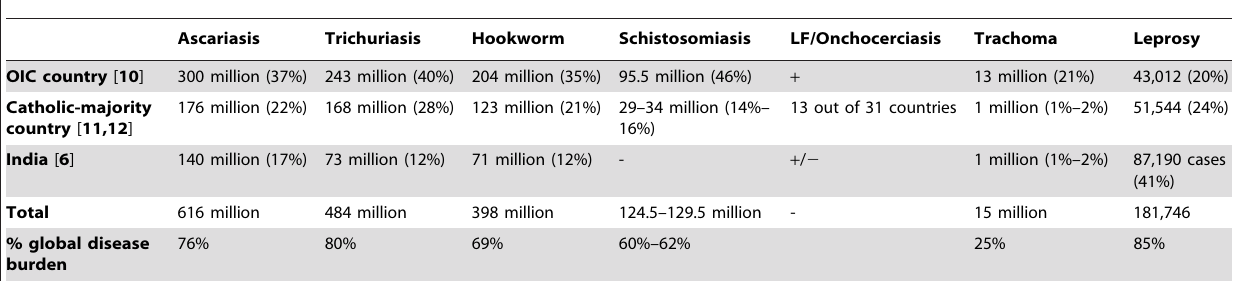
Table 2. NTDs in the member nations of the Organisation of the Islamic Conference (OIC), Catholic-majority countries, and